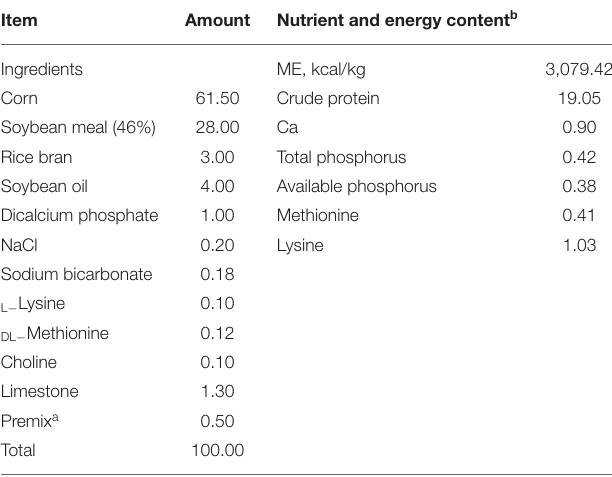
TABLE 1 | Composition and nutrient levels of the basal diets (air-dry basis,